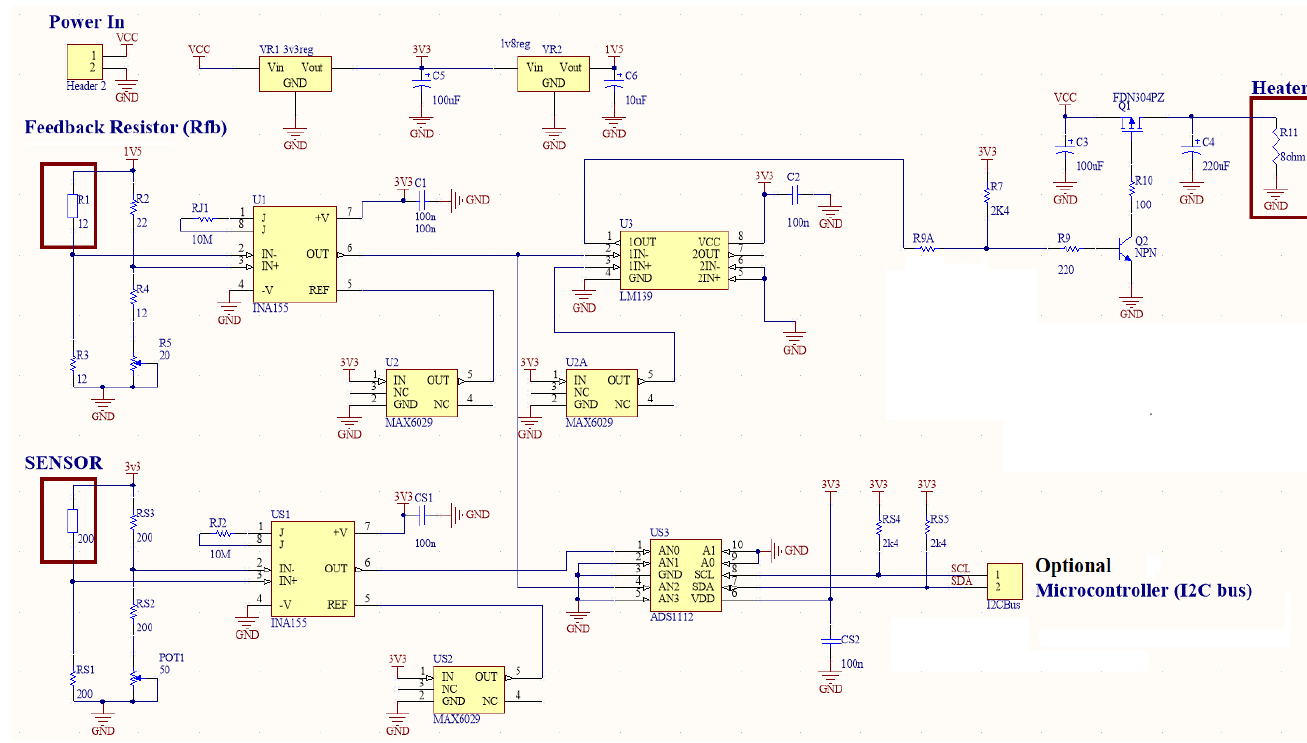
Figure 6. Feedback-controlled heater solution.